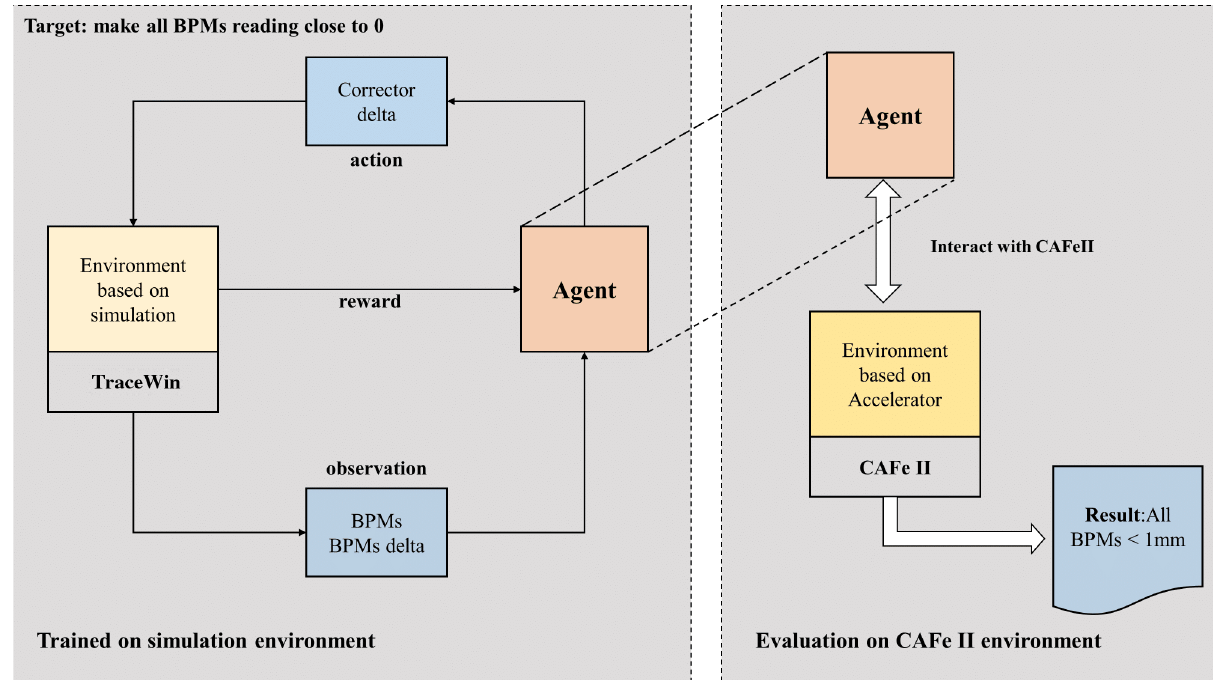
FIG. 1. Overview of the orbit correction method. The agent interacts with a simulation environment which is built by T race W in . The agent determines the values of the corrector magnets according to the variation of the BPM readings. The goal of the agent is to maximize the expectation of reward in each episode. Once the model is trained on the simulated environment, it can be evaluated on CAFe II without any online